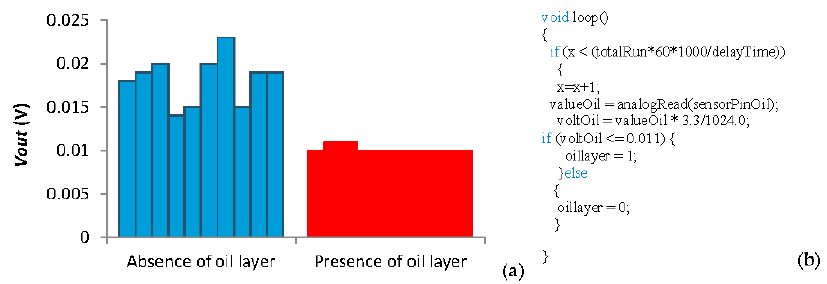
Figure 12. ( a ) Data and ( b ) code of the oil layer sensor.